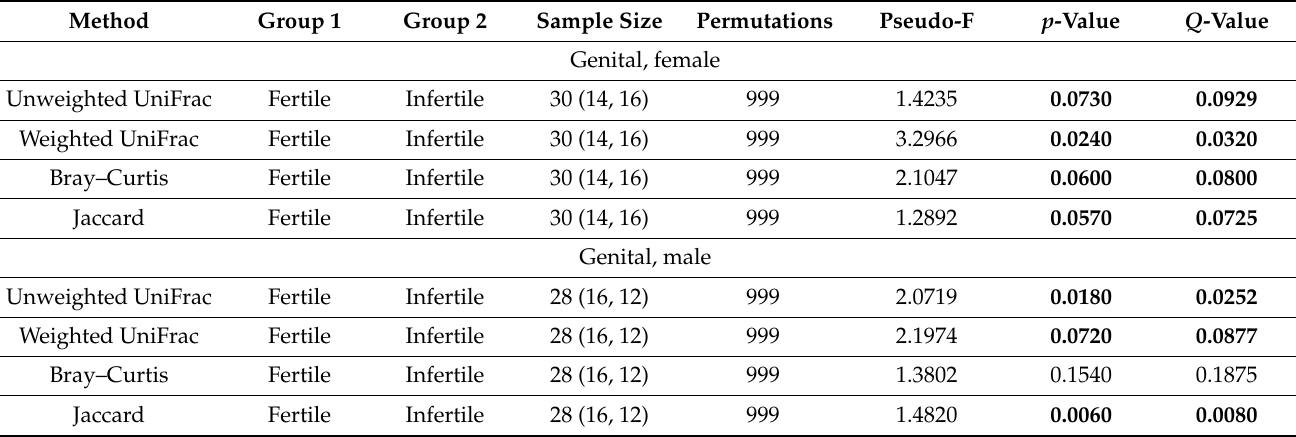
Table 4. Differences in the beta-diversity among samples, as evaluated by pairwise PERMONVA with 999 permutations. (<0.1 are in bold).